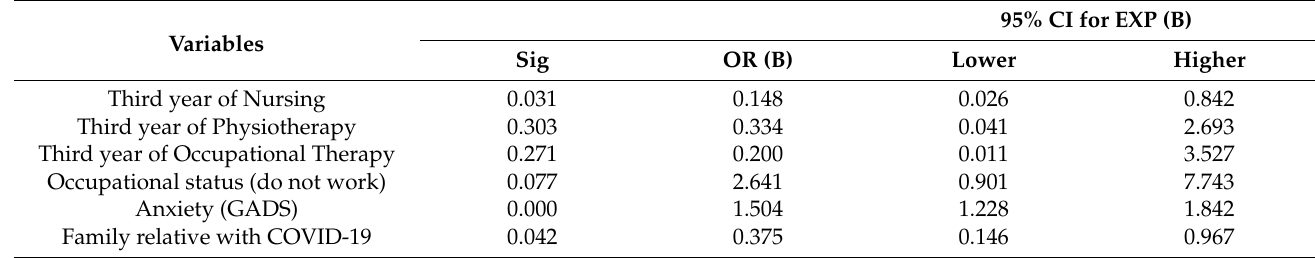
Table 4. Binary logistic